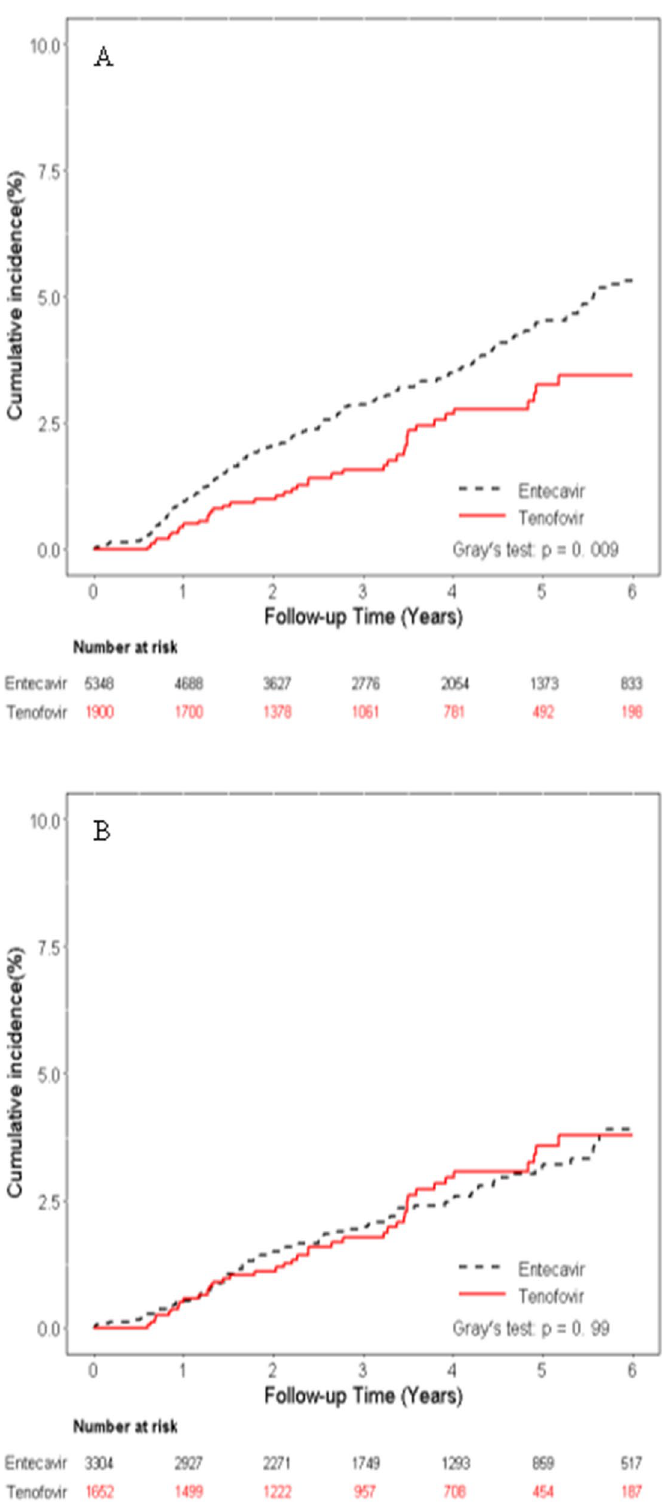
Figure 4. Cumulative incidences of liver-related death. ( A ) Entire cohort ( B ) Propensity score matching